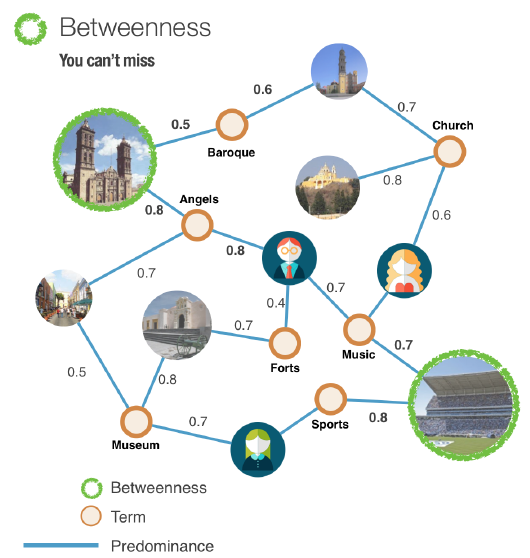
Figure 4: “You can’t miss” as a result of computing flow between- ness.